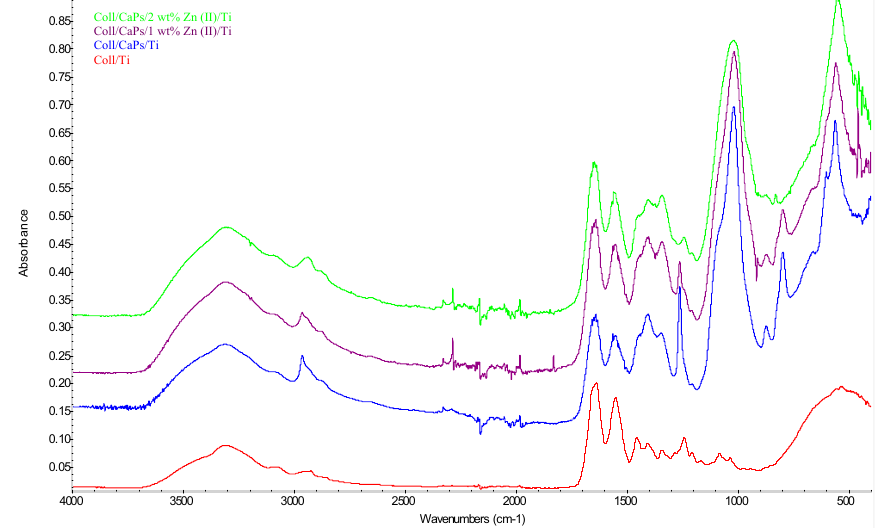
Figure 2. FTIR spectra of the Coll/Zn(II)-CPs biocomposites deposited on Ti substrates.